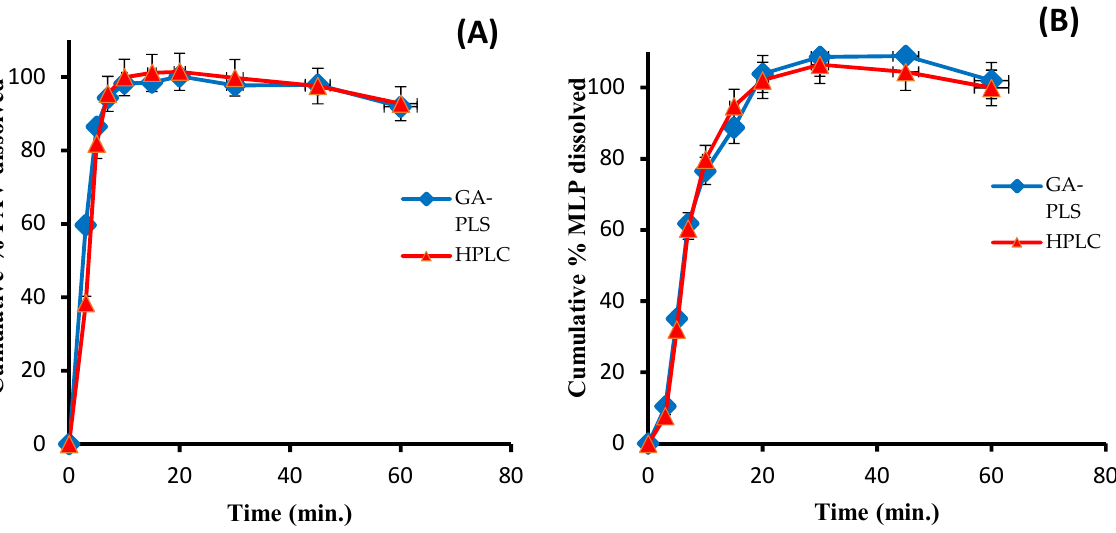
Figure 6. The simultaneous in vitro HPLC and GA–PLS-1 dissolution profiles of ( A ) Molcovir ® capsules and ( B ) Epifluver ® tablets.